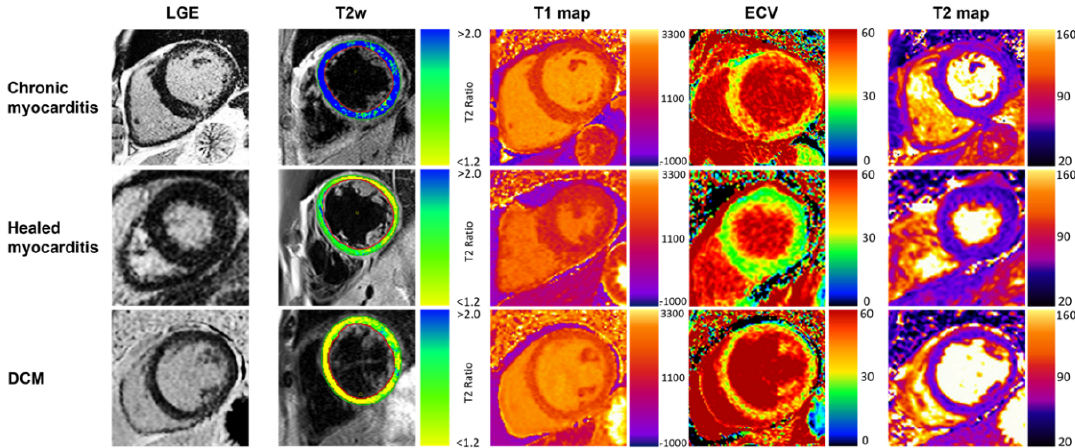
Figure 6. Typical CMR findings of chronic healed myocarditis and DCM. Compilation of typical LGE, T2w, T1 and ECV, and T2 mapping appearance in chronic and healed myocarditis plus DCM patients. T2w and T2 mapping show present edema in chronic myocarditis. Increased T1 relaxation times and ECV were present in all groups, prominently depicted in the chronic myocarditis and DCM examples.